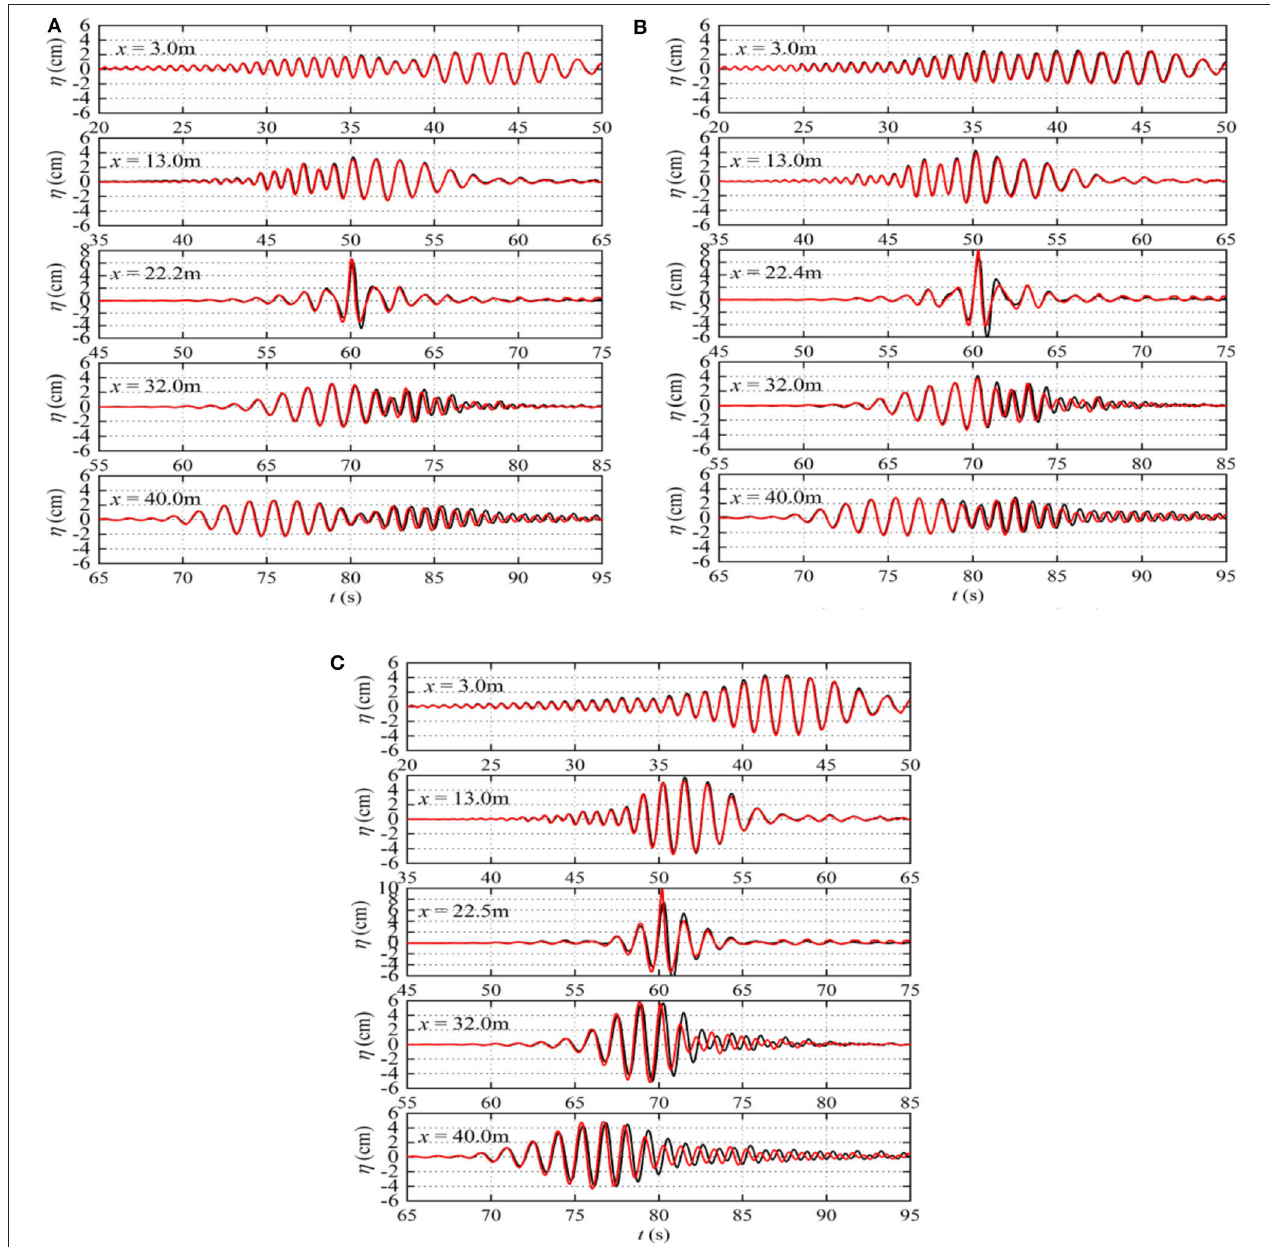
FIGURE 5 | The comparisons of the surface elevations between the linear superposition of the corresponding single wave group focusing and the double wave groups focusing (black solid lines represent the linear superposition of single wave group focusing, and red solid lines represent the double wave groups focusing). (A) Case 1_AB, (B) Case 2_AB, (C) Case